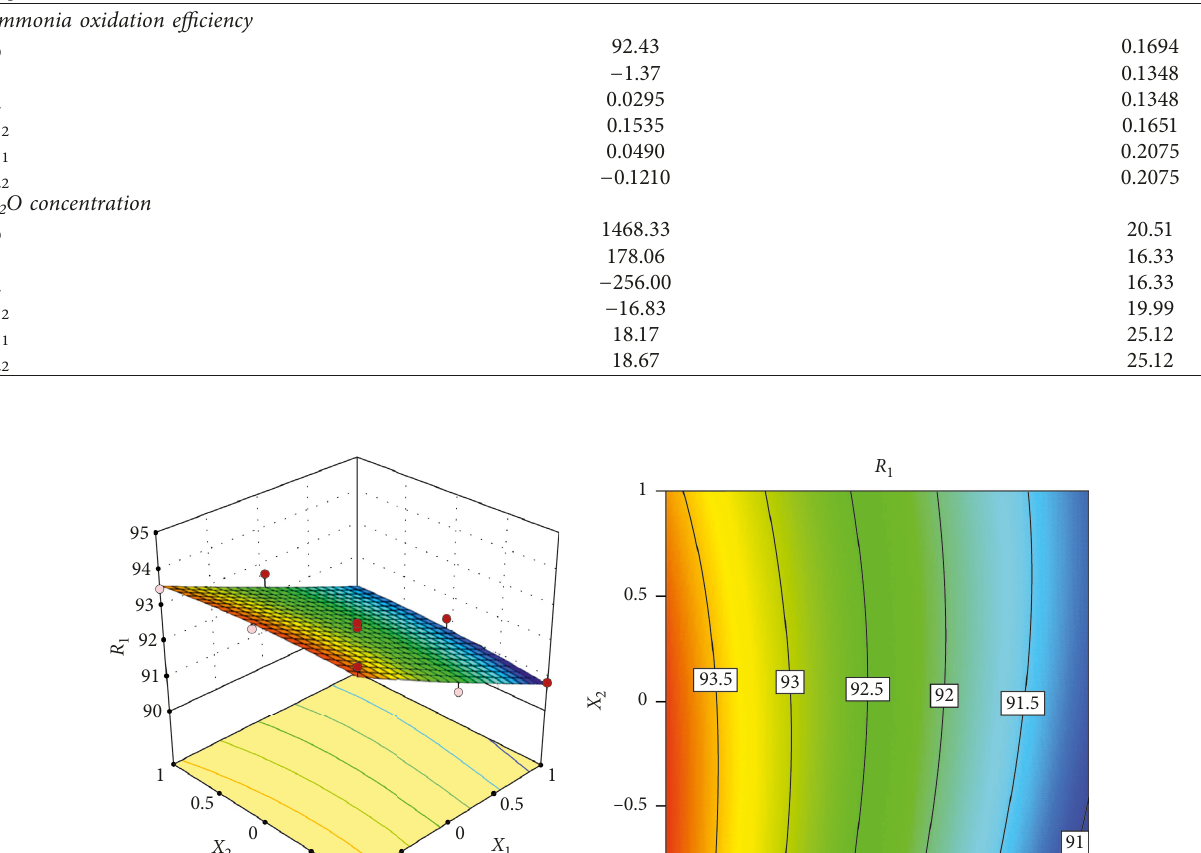
1 ) and N 2 O concentration